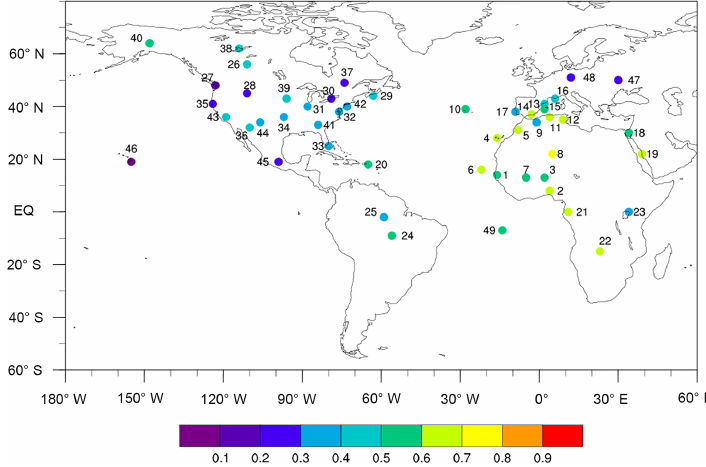
Figure 6. Correlation map of total AOT at 550nm between NGACv2 and AERONET sites. Approximate location of AERONET centers in the map represented as filled circles. Name and location of these sites are listed in Table 2.